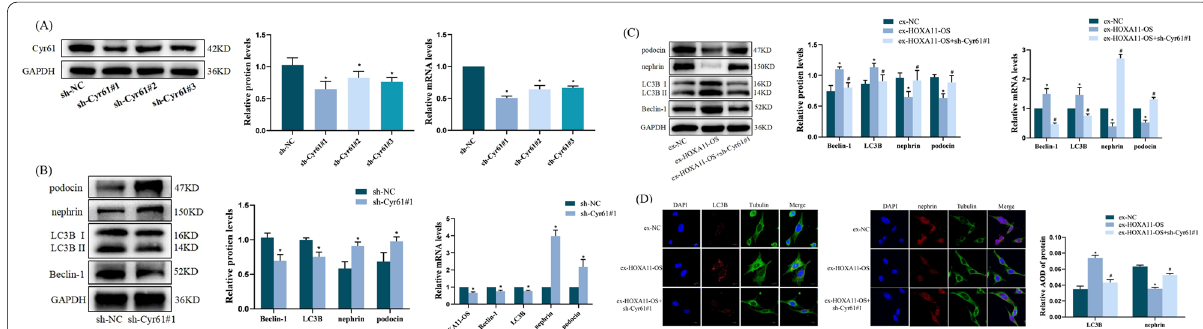
Fig. 5 The downregulation of Cyr61 gene can reverse the abnormal autophagy and podocyte injury induced by HOXA11-OS. A The Cyr61 gene was downregulated by knockdown lentivirus transfected into podocytes, and its expression was detected by qRT-PCR and western blotting. B The expression of HOXA11-OS, Beclin-1, LC3B, nephrin, and podocin was detected by qRT-PCR and western blotting after Cyr61 downregulation. * P < 0.05 vs. sh-NC. C The expression of Beclin-1, LC3B, nephrin, and podocin was detected by qRT-PCR and western blotting after sh-Cyr61#1 was transfected into the ex-HOXA11-OS cell line. D The localization and expression of LC3B and nephrin were detected by IF. * P < 0.05 vs. ex-NC; # P < 0.05 vs. ex-HOXA11-OS. Data are presented as means standard deviation. Scale bars represent 15 ±